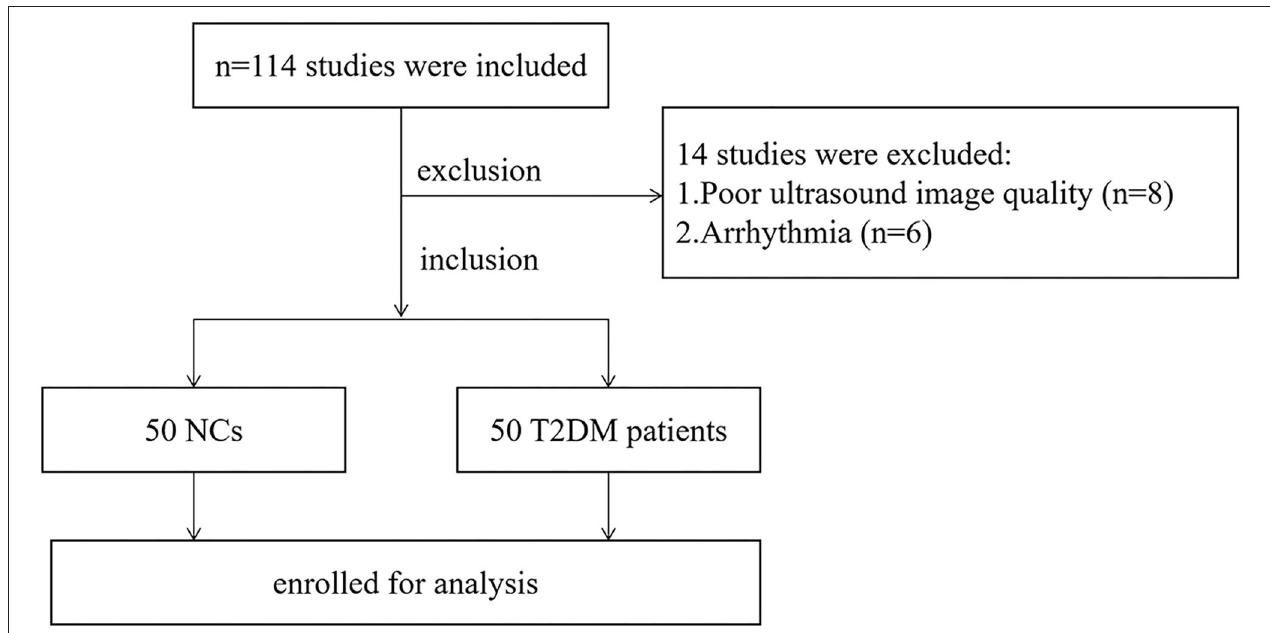
FIGURE 1 | Flow chart of participants inclusion in the T2DM and NC groups. T2DM, type 2 diabetes mellitus; NC, normal control.